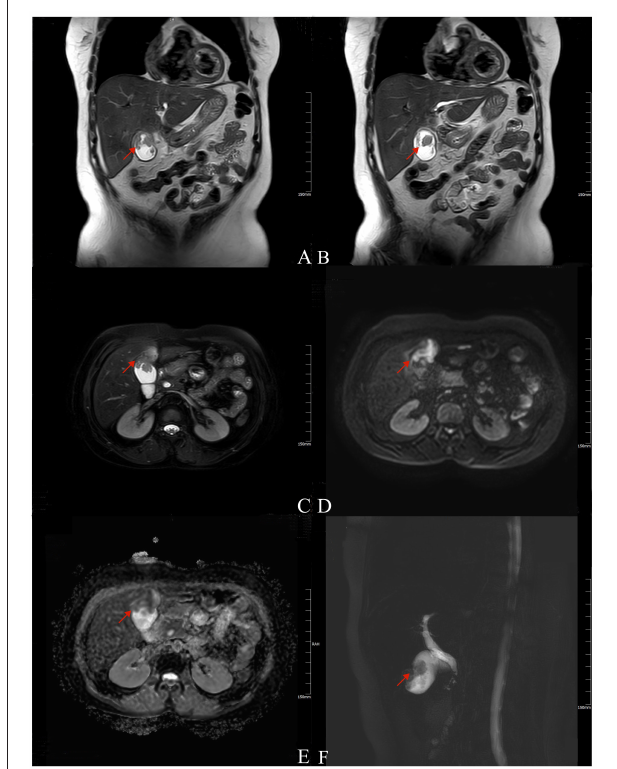
FIGURE 1 | Magnetic resonance imaging (MRI) findings of the patient. T2-weighted (A,B, coronal; C , axial ) imaging showed low signal intensity as an irregular filling defect in the gallbladder fundus and long signal in segment IV of the near liver (arrow). DWI (D) showed a hyperintense signal, and ADC map (E) showed reduced diffusion (arrow). MRCP (F) showed gallbladder enlargement with local filling defect (arrow).